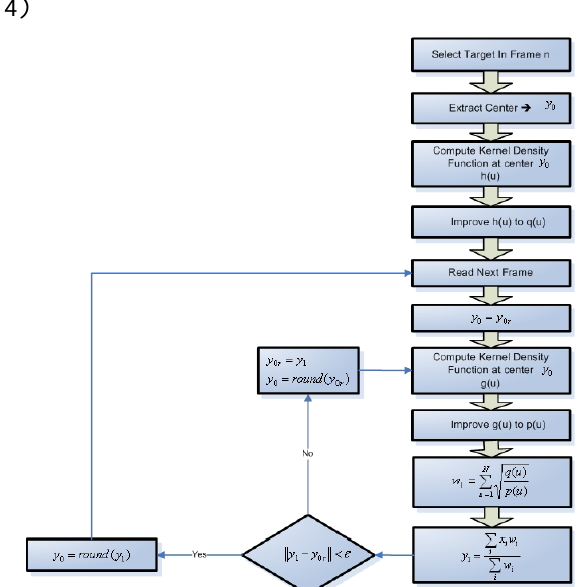
Figure 4.Complete block diagram of the mean shift